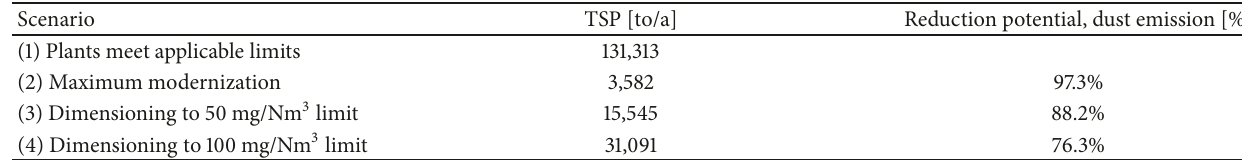
Table 7: Results of various